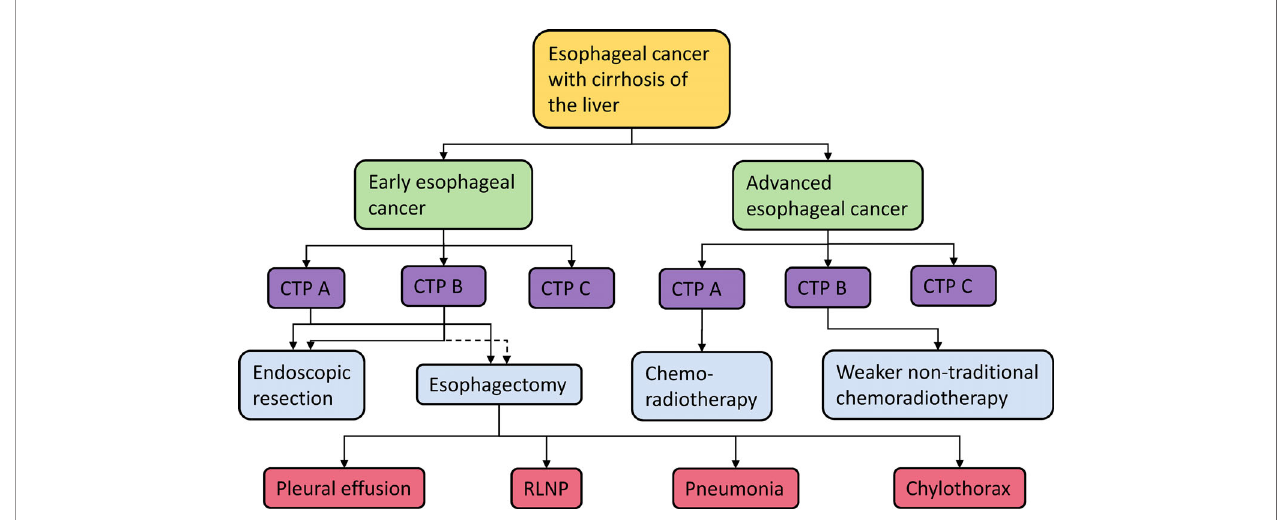
FIGURE 2 | Esophageal cancer treatment options and their possible complications (The dotted line indicates inconsistent conclusions about whether patients can accept this treatment method). CTP A/B/C, Child – Turcotte-Pugh score A/B/C; RLNP, recurrent laryngeal nerve